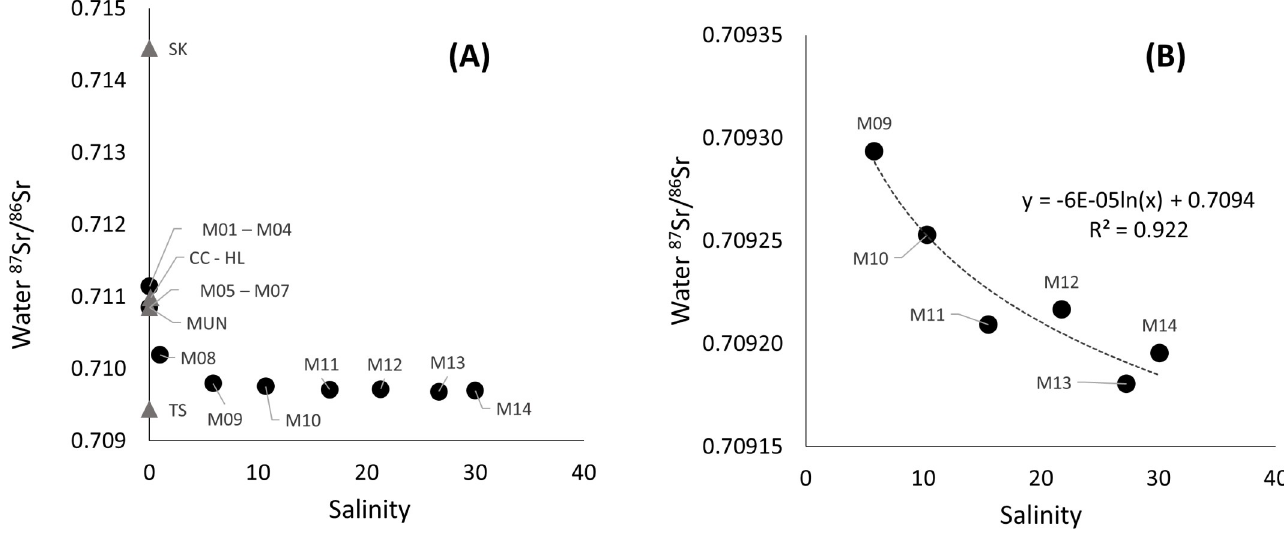
Fig 3. Water 87 Sr/ 86 Sr versus salinity along the Mekong River. Water 87 Sr/ 86 Sr versus salinity along the Mekong mainstream (dark circles) and tributaries / distributaries (grey triangles); (A) for all sampling locations, and (B) only in saline waters (Mekong Delta) with a logarithmic regression. Labels at each point refer to the sampling sites in Fig 1 and Table